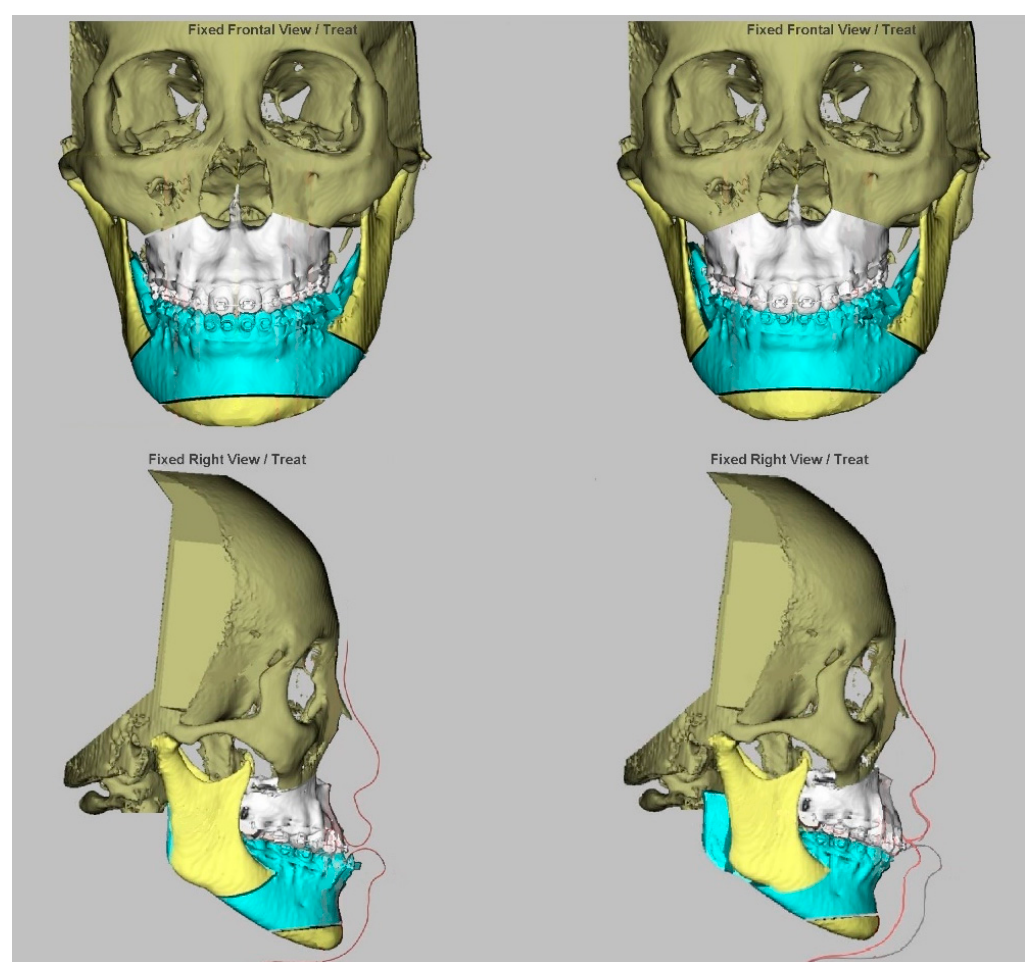
Figure 1. Virtual imaging-assisted simulation of single-splint two-jaw orthognathic surgery technique (final occlusal splint, 1-piece Le Fort 1 maxillary osteotomy, and bilateral sagittal split osteotomy) for correction of skeletal Class III deformity. ( Right ) Before ( left ) and after mobilization of the maxillomandibular complex, including translational (advancement) and rotational (pitch clockwise) to achieve a symmetric, balanced, and proportional face. The maxillomandibular complex rotations in the yaw and roll directions were also adopted for final skeletal positioning and adjustments, such as the elimination of residual asymmetry of contour and interference between the osteotomized bony structures and regions at the pterygoid maxillary junction and mandibular ramus areas.